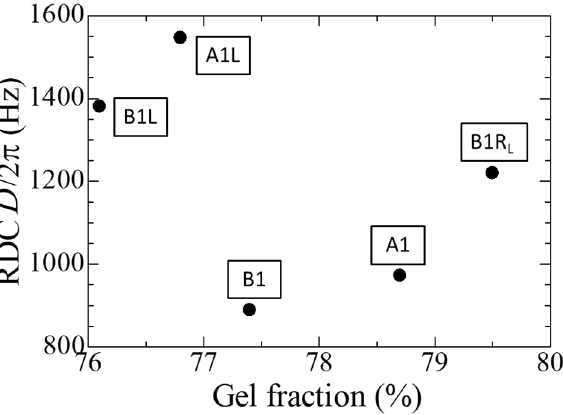
Figure 12. Residual dipolar coupling (RDC) measured for the five tubular samples as a function of gel